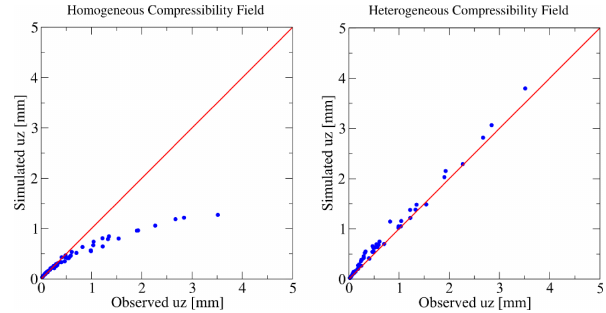
Figure 9. Simulated vs. observed values of u z in test case 1 (homo- geneous c M ) and test case 2 (heterogeneous c M